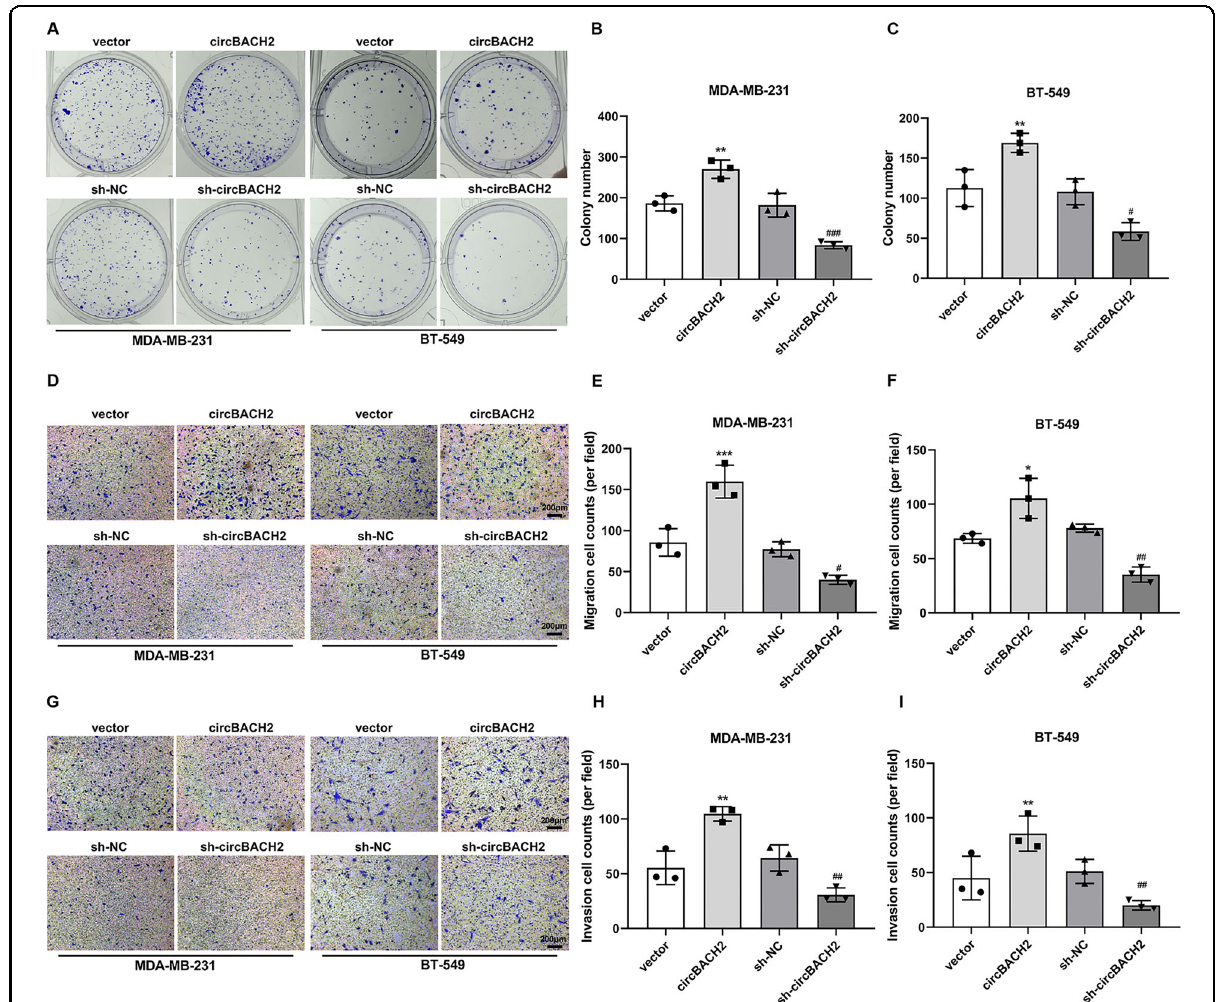
Fig. 3 circBACH2 enhanced in vitro migration-invasiveness of TNBC cell lines. A – C The proliferation of MDA-MB-231 and BT-549 cells transfected with indicated vectors was evaluated using colony formation assay and quanti fi ed. D – F Migration of MDA-MB-231 and BT-549 cells transfected with indicated vectors was evaluated using Transwell assay and quanti fi ed. G – I Invasion of MDA-MB-231 and BT-549 cells transfected with indicated vectors was evaluated using Transwell assay and quanti fi ed. * P < 0.05, ** P < 0.01, *** P < 0.001 vs vector; # P < 0.05, ## P < 0.01, ### P < 0.001 vs